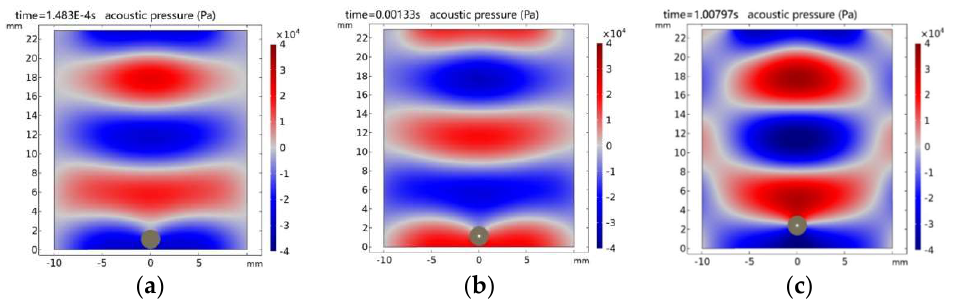
Figure 8. Dynamic simulation of acoustic cavitation and acoustic levitation: ( a ) Droplet and standing wave field. ( b ) Cavitations’ bubble in droplet. ( c ) Droplets suspended at standing wave node.